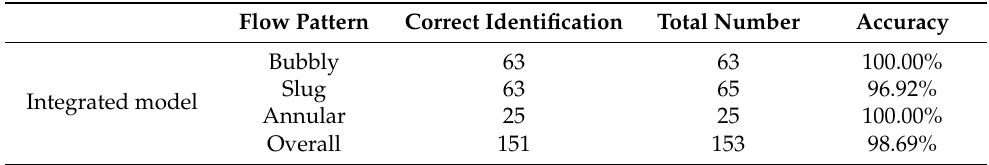
Table 10. Identification results of integrated